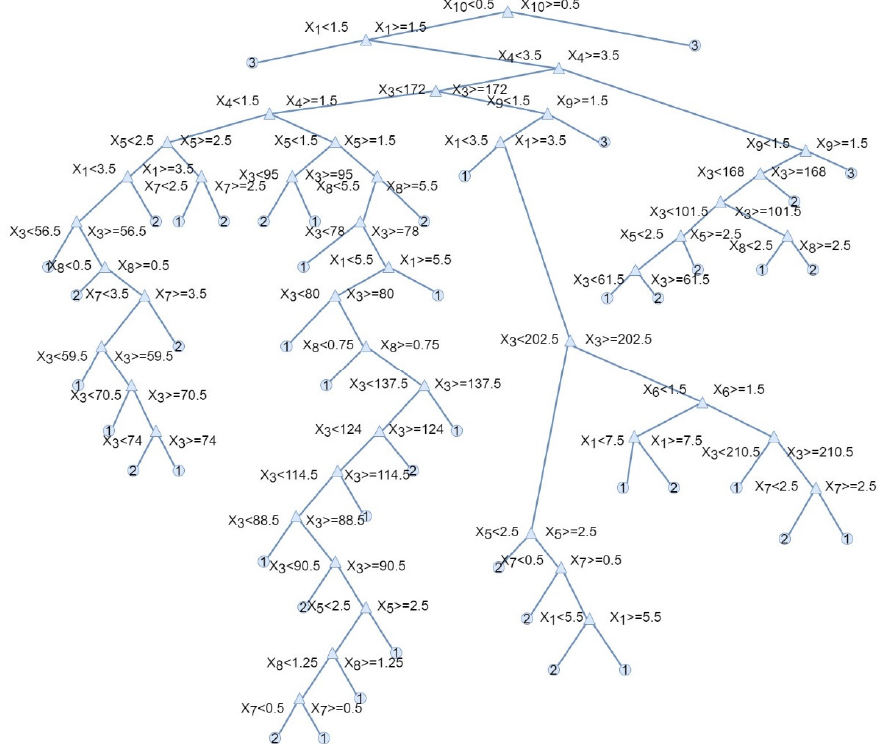
Figure 5. Complex tree.